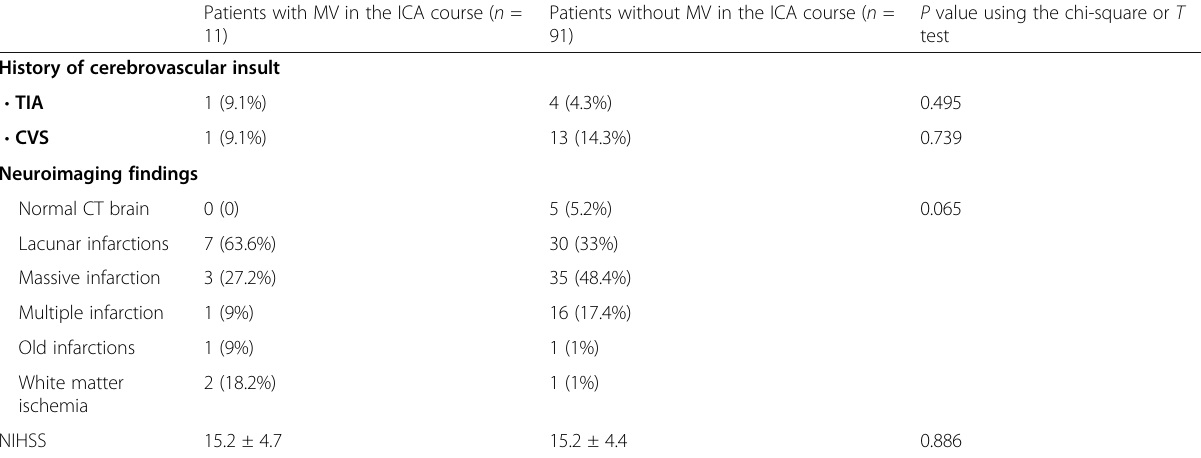
Table 3 Demographic and clinical data of ischemic stroke patients with and without internal carotid artery morphological variations Patients with MV in the ICA course ( n = 11)